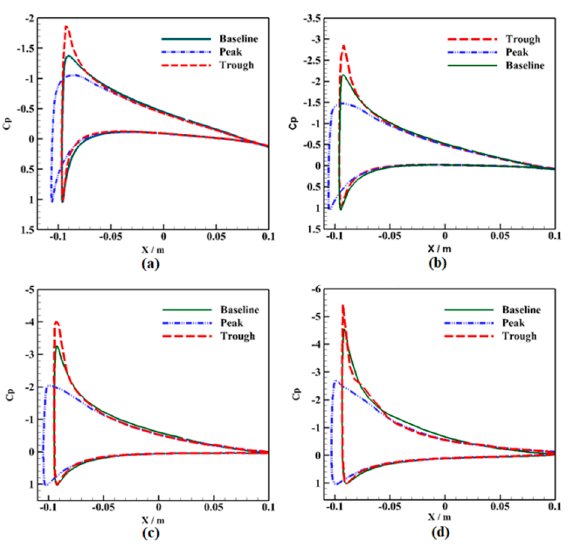
Figure 14. Comparison of pressure coefficients for different angles of attack. ( a ) 5.8 ° ↑ ; ( b ) 8.5 ° ↑ ; ( c ) 11.2 ° ↑ ; ( d ) 14.0 ° ↑ .